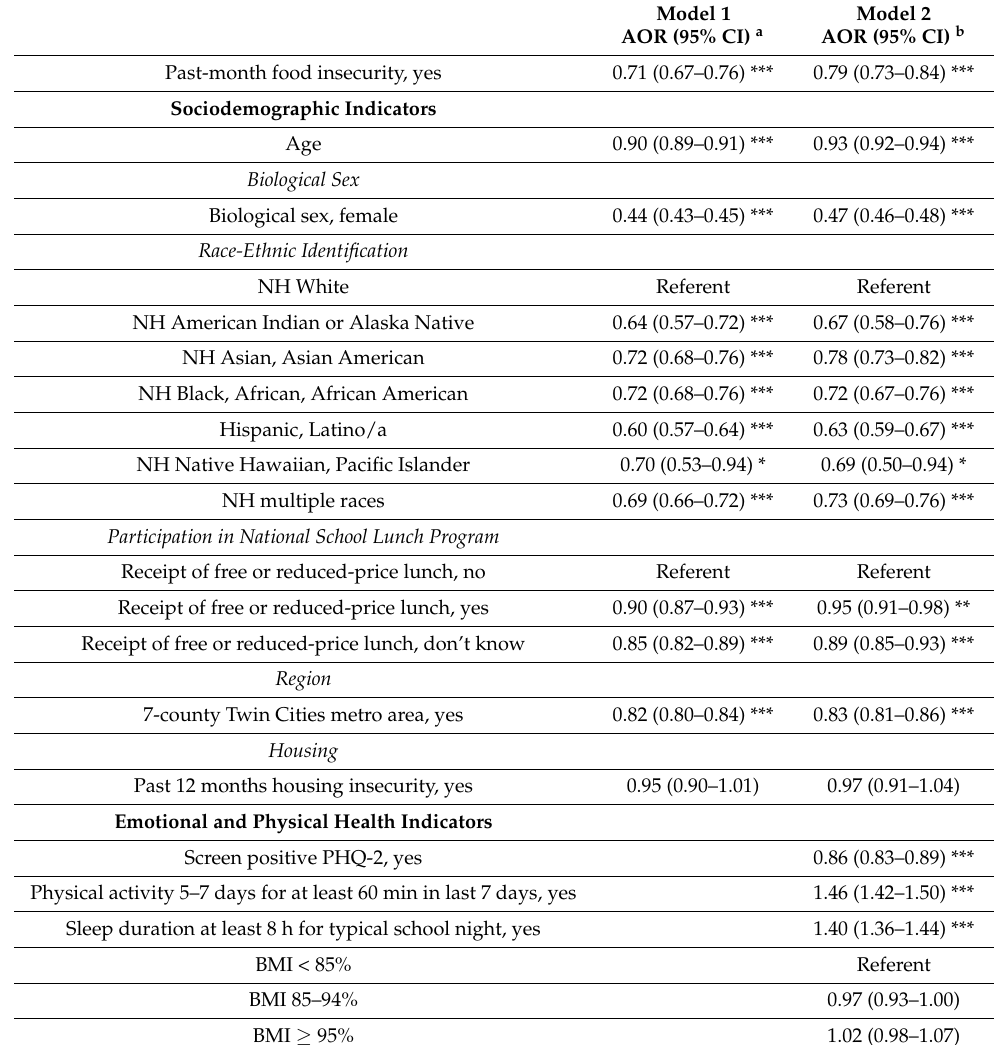
Table 3. Past-Month Food Insecurity and Student Consumption of Milk One or More Times/Day, Past 7